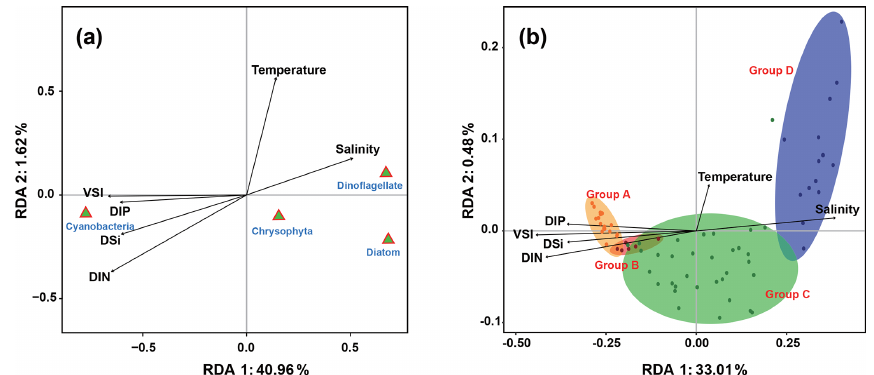
Figure 8. Redundancy analysis of the (a) phytoplankton and environmental parameters. (b) Groups and environmental parameters in the WPO. Colored dots represent sampling sites, triangles represent phytoplankton species, and arrows represent environmental factors.